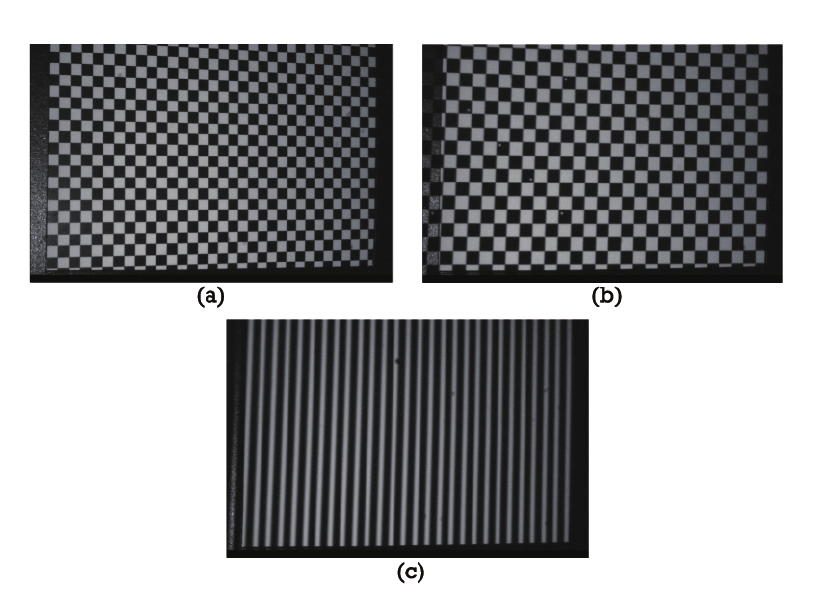
Figure 4. Calibration fringe patterns: ( a ) checkerboard for the camera calibration; ( b ) projected checkerboard for the projector calibration; and ( c ) projected sinusoidal fringe pattern for the depth